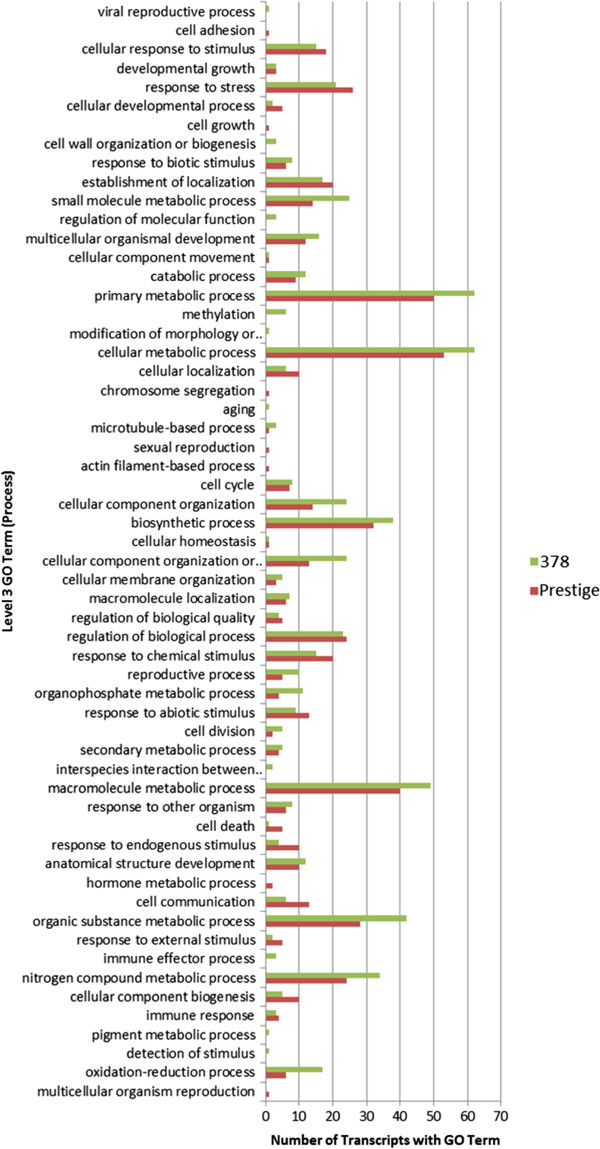
Number of significantly expressed genes in each of the Level 3 GO biological processes. Transcripts with higher expression in ‘Prestige’ than in ‘378’ are in red. Transcripts with higher expression in ‘378’ than in ‘Prestige’ are in green.